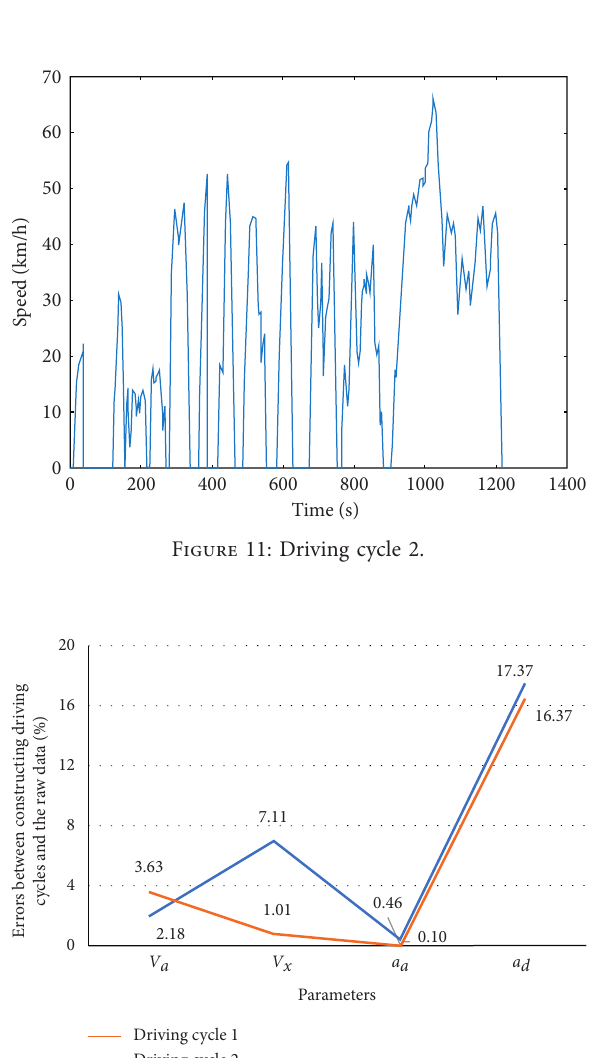
Figure 12: Errors between the two cycles and the experiment data (parameters on speed and